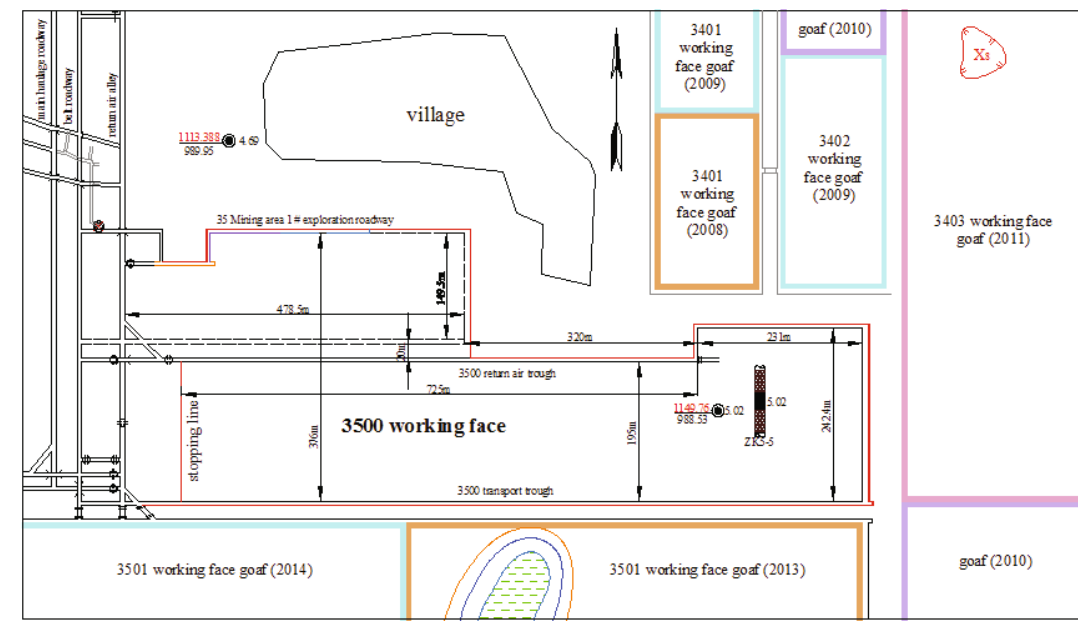
Figure 1: Layout of 3500 Working Face and mining dates of goafs. Table 1: Distribution and physical and mechanical characteristics of the coal seam and roof strata of 3500 Working Face. Strati fi cation